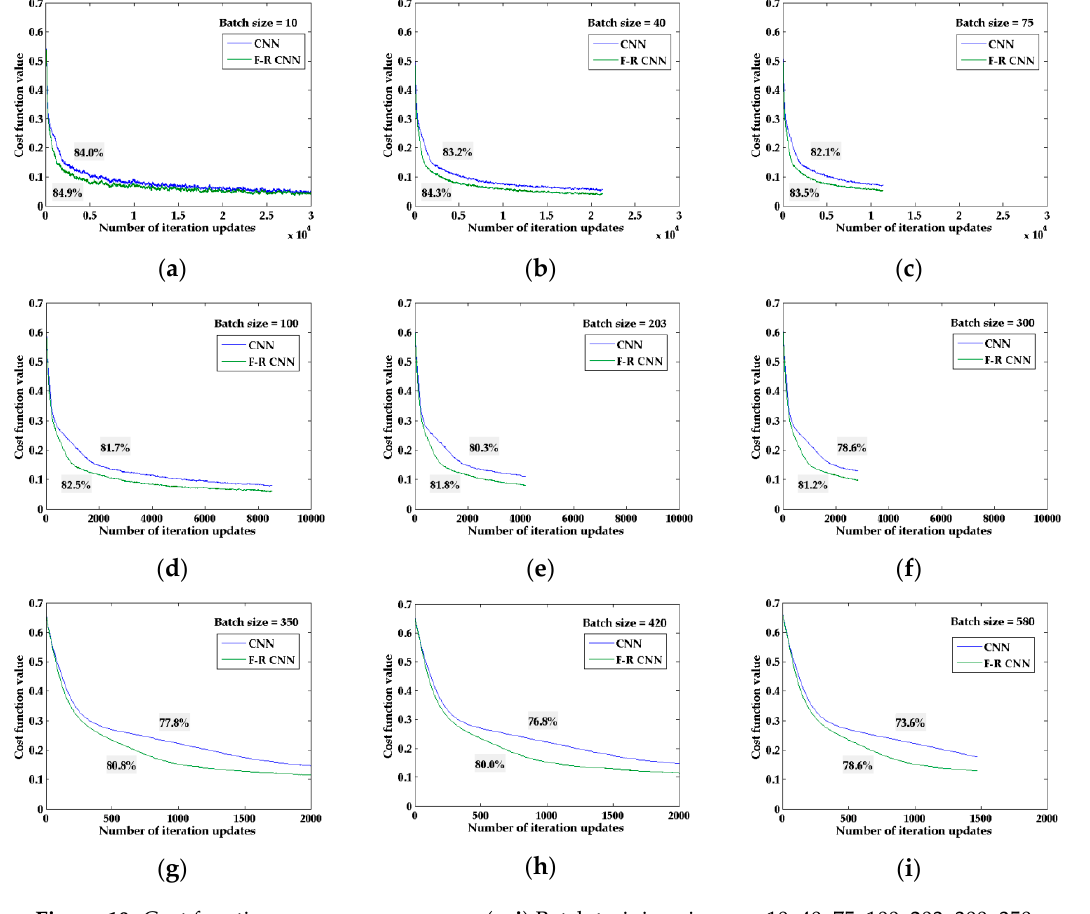
Table 8. Convergence of traditional CNN models in different number of batch training samples. CNN Batch Size